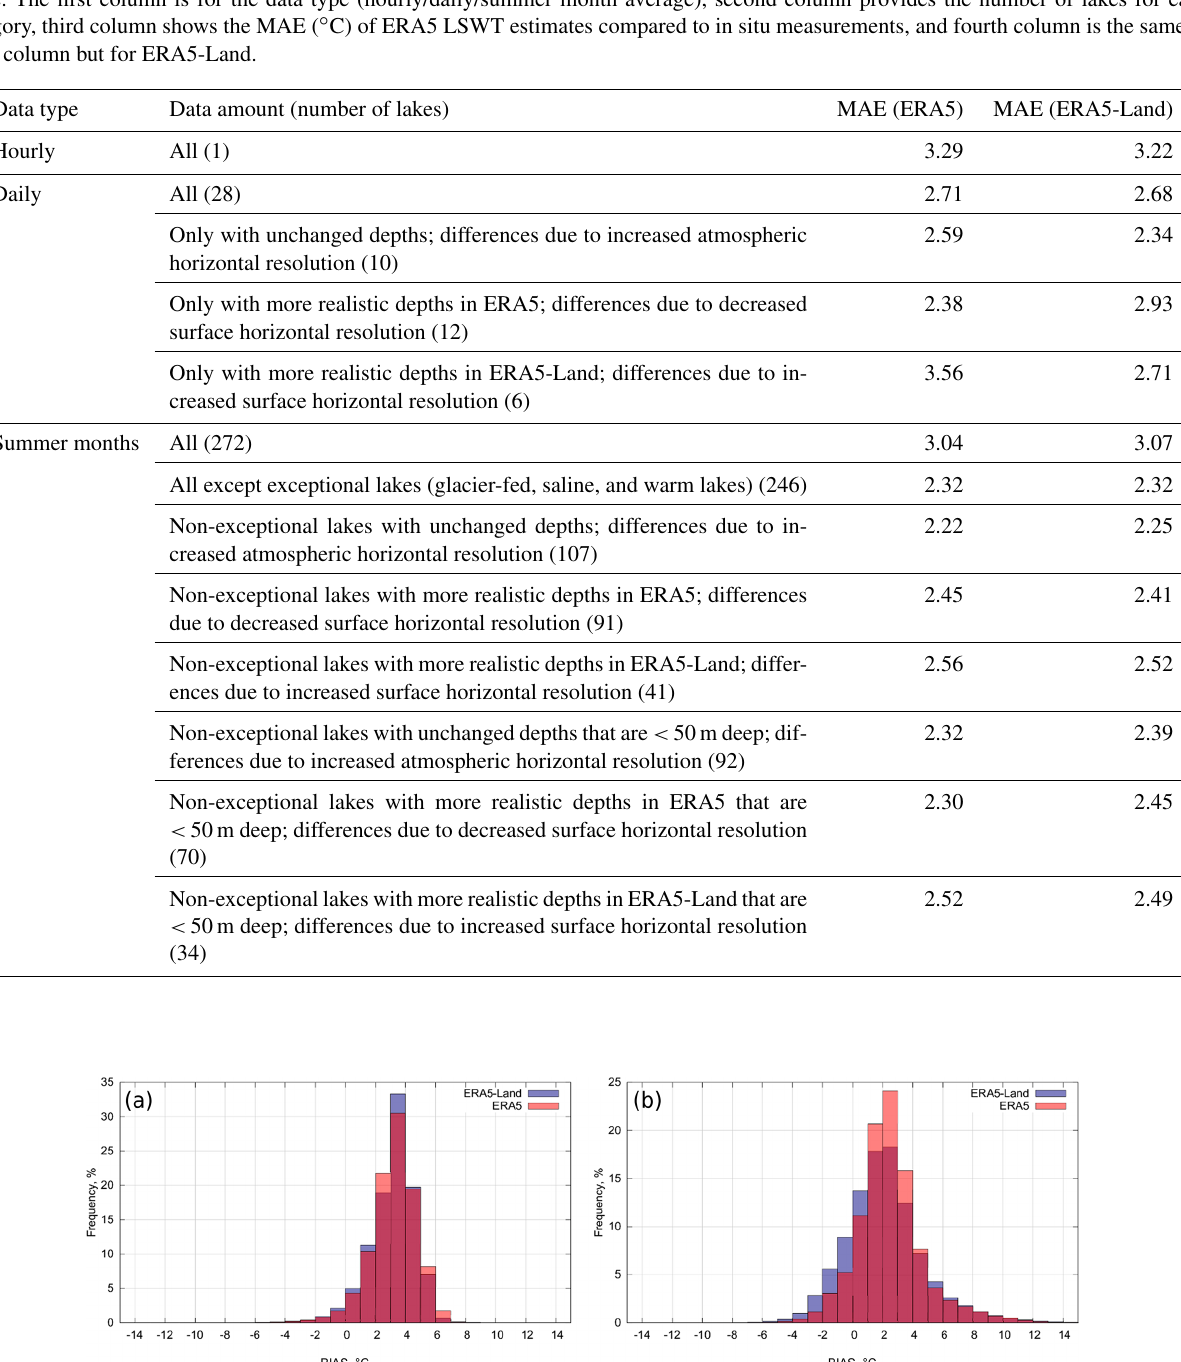
Figure 11. LSWT bias (observations minus ERA5 or ERA5-Land estimates) distribution ( ◦ C) for hourly data from the Alqueva reservoir (a) and daily data from the Alqueva reservoir and the Finnish lakes (b) . The dark red colour represents the area where both ERA5 (pink colour) and ERA5-Land (violet colour) bias distribution